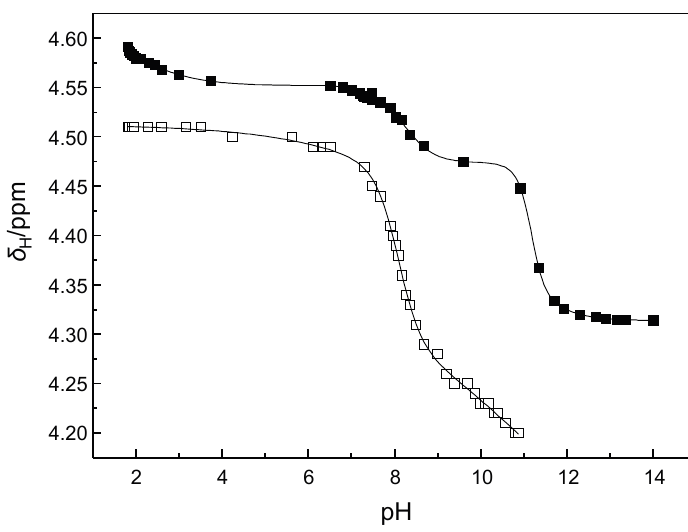
Figure 2. Chemical shift of the methylene protons of 11a (  ) and 11b (  ) as a function